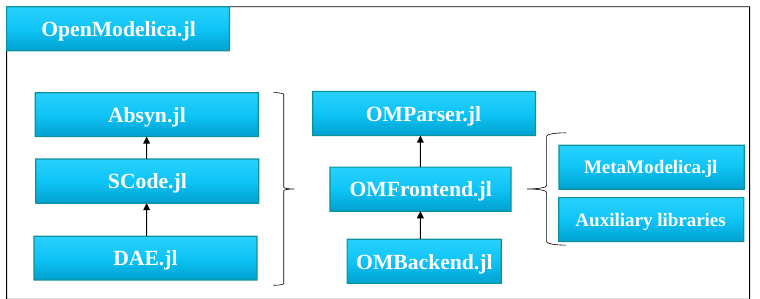
Figure 2. An overview of the dependencies between the components in OpenModelica.jl. Absyn.jl, SCode.jl and DAE.jl are the compilers’ intermediate representations. The compiler runtime is imple- mented by MetaModelica.jl and auxiliary libraries. The frontend is provided by OMFrontend.jl and the backend is defined by